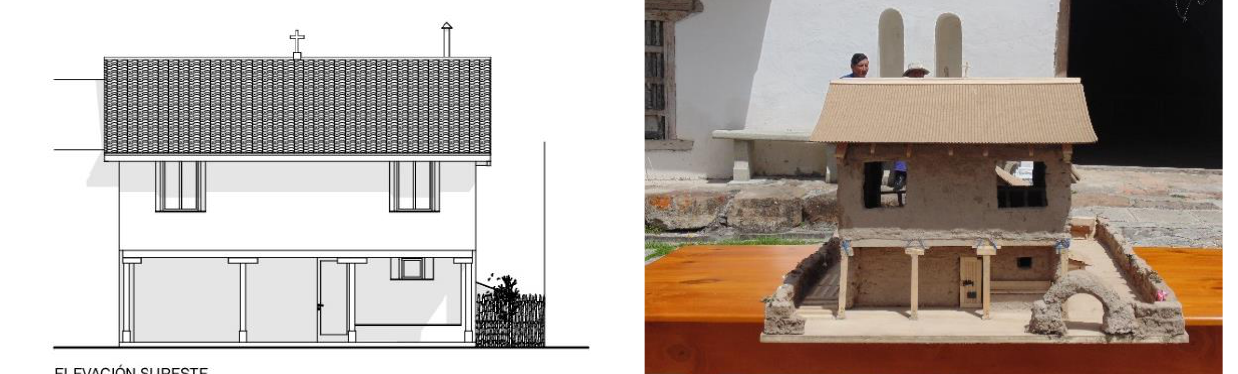
Figure 5. b) House designed for the consolidated context. Source: Photographic Repository of the Ciudad Patrimonio Mundial project.